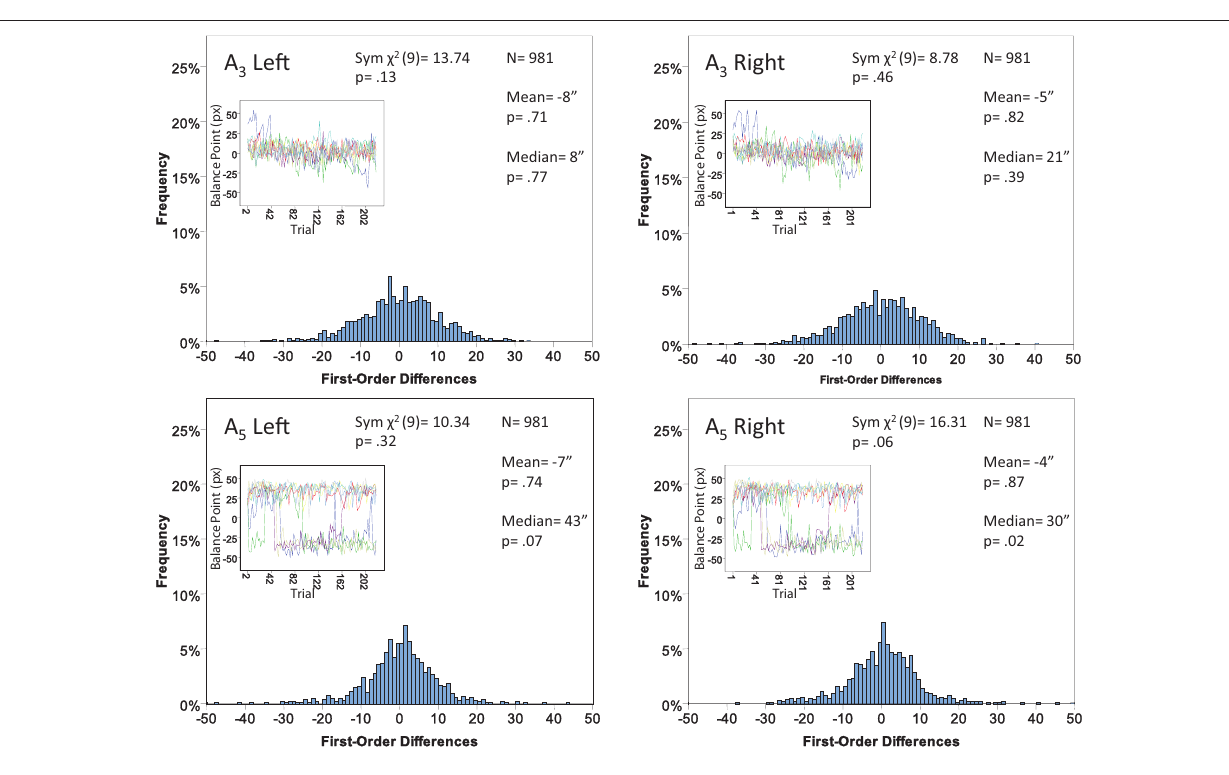
Figure 12 | Histograms of the ∆ ’s for the shape experiment, participant P4. The rest as in Figure